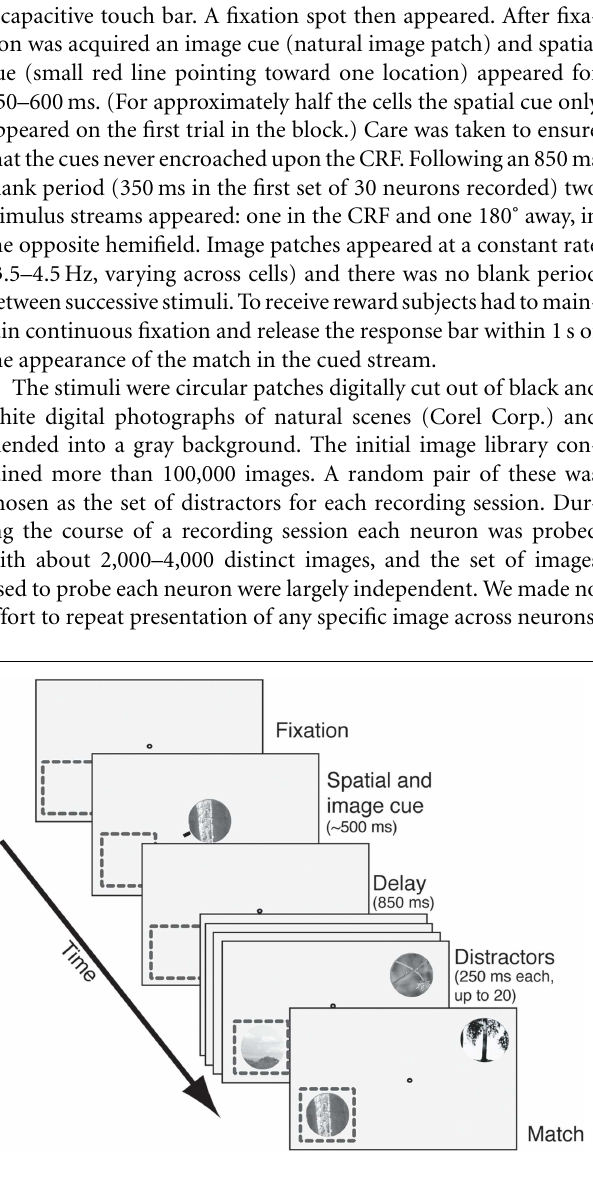
FIGURE 1 |The delayed match-to-sample task. After fixation was acquired, an image cue was presented centrally. A small red line (spatial cue) designated the relevant search stream. After a delay period (850ms in most cells, 350ms in the rest), two streams of images appeared. One stream appeared in the receptive field (dashed square) and the other appeared in the opposite quadrant. Images appeared at approximately 4Hz with no blank interval between successive images. Reward was given for bar release within 1s after the match appeared in the cued stream. Failures to release, early releases, and fixation breaks at any time were considered errors.The match and all distractors were circular patches selected from photos and fit to the size of the neuron’s receptive